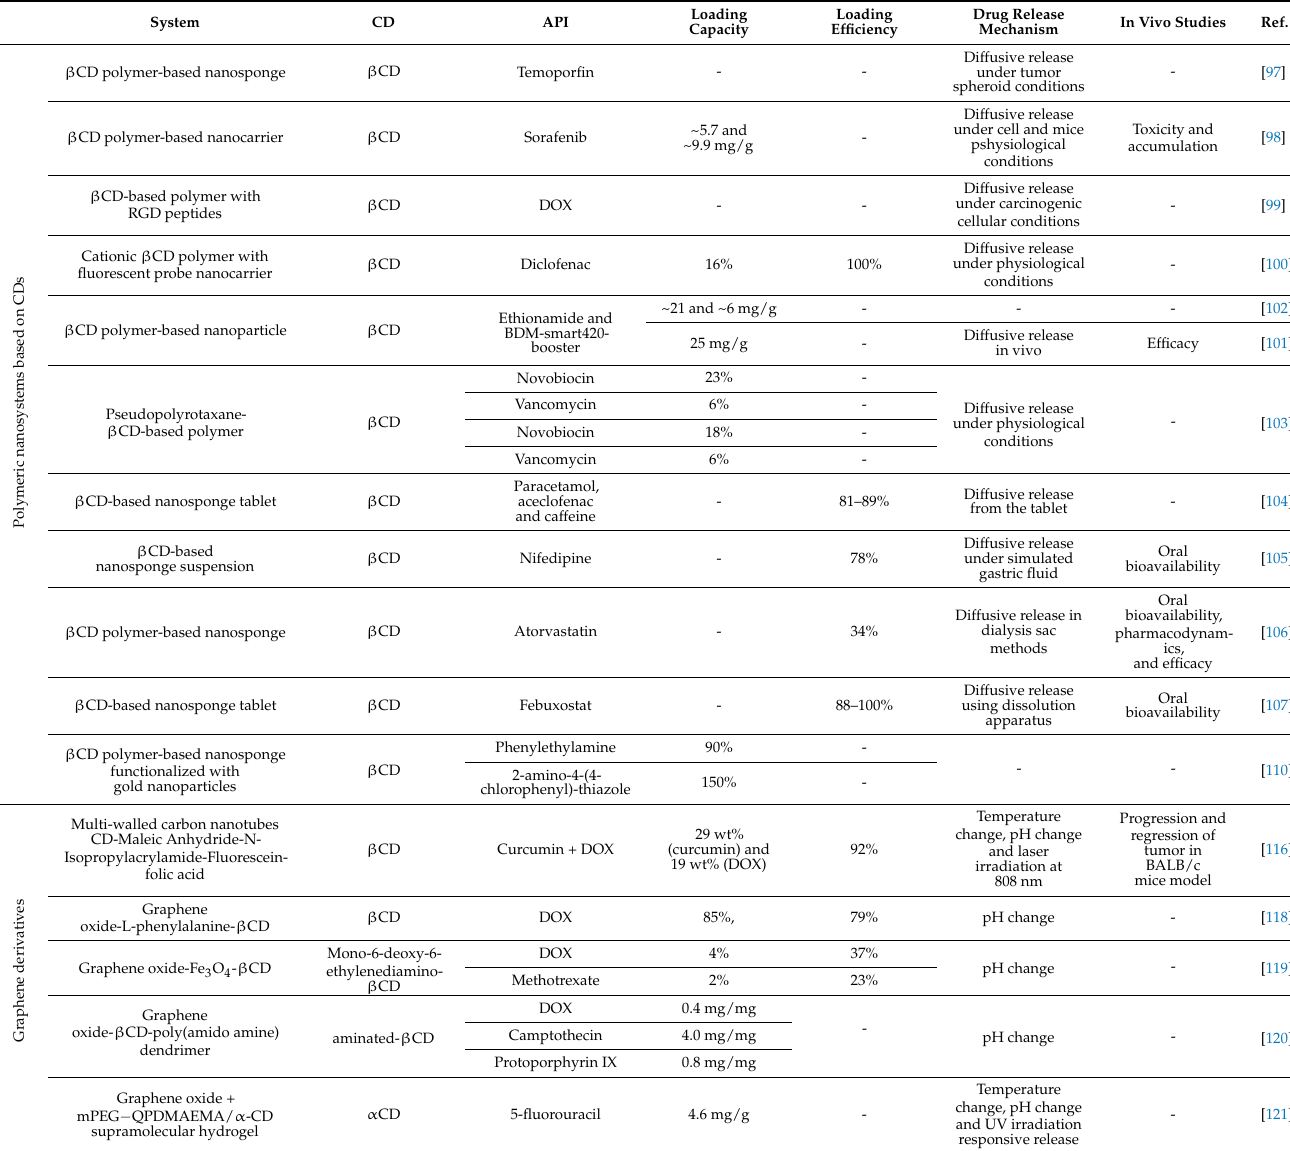
Table 2. Summary of the most important data based on the qualification according to the type of nanosystem, type of CD used, types of polymers, and results regarding drug loading, release mechanism, and in vivo studies (if available) from Sections